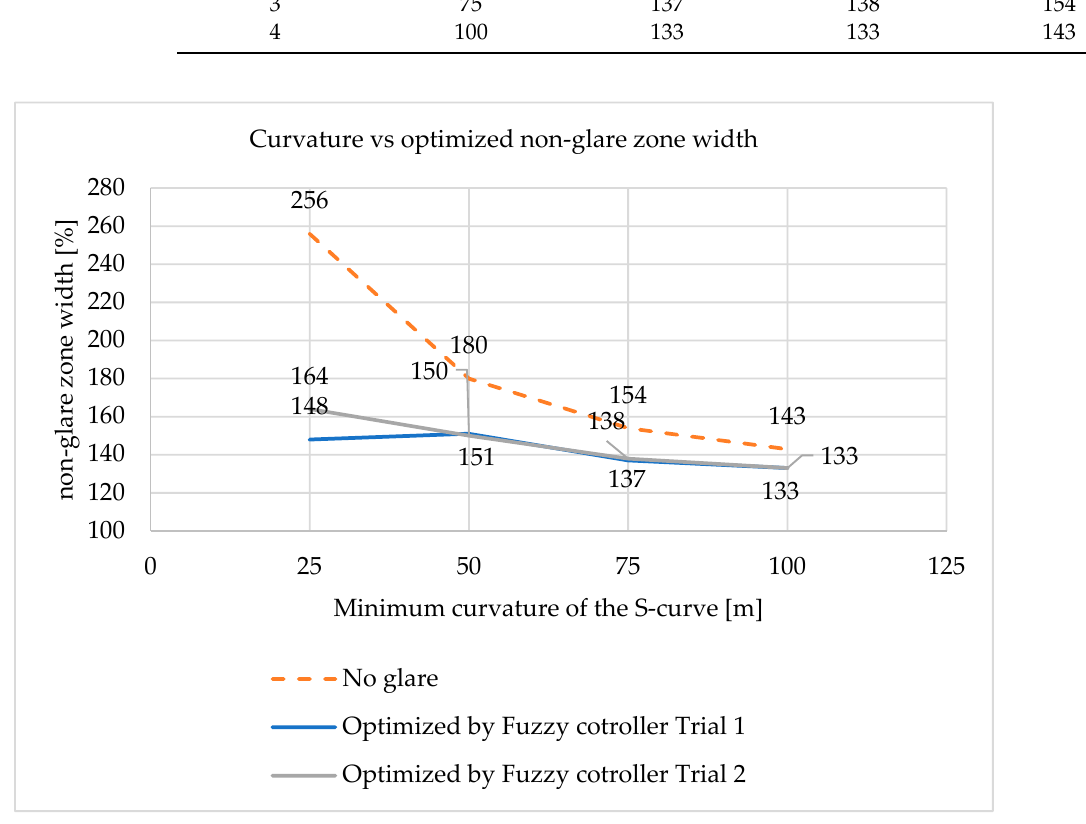
Figure 14. The minimum curvature in the driving scenario vs. best non-glare zone width.